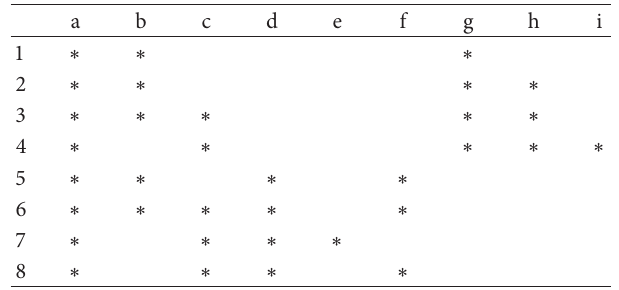
Table 1: Formal context “biology and